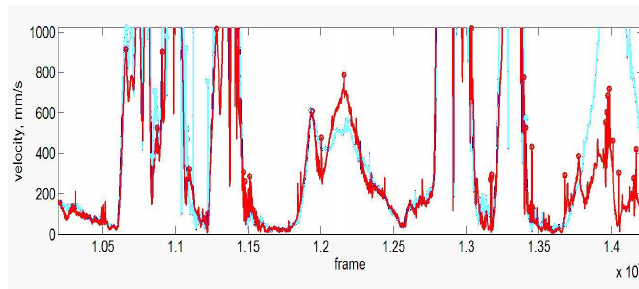
Fig. 6. Example of peaks of velocity (blue refers to the RSHD marker, red to the RWRS marker) for participant #5